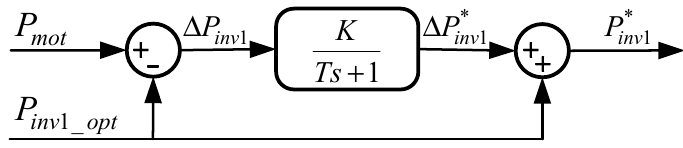
Figure 4. Calculation diagram of desired power of inverter1.